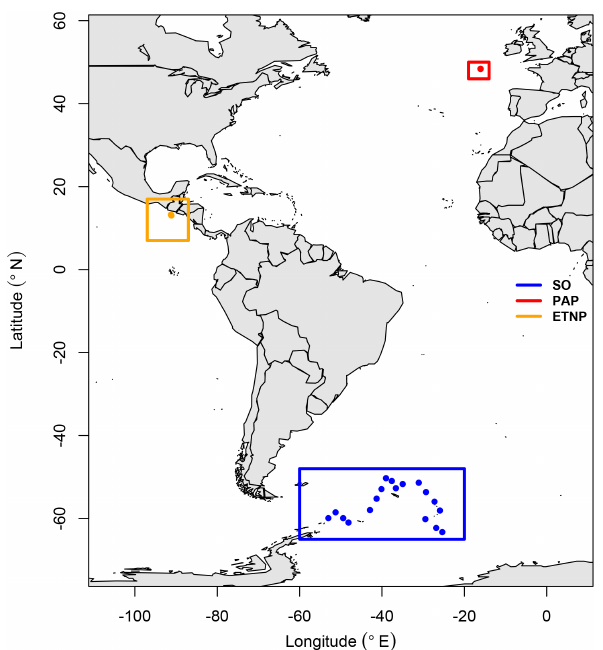
Figure 1. Map showing study areas. Blue rectangle is location of sites in the Southern Ocean, red is the North Atlantic Porcupine Abyssal Plain, and orange the equatorial North Pacific oxygen min- imum